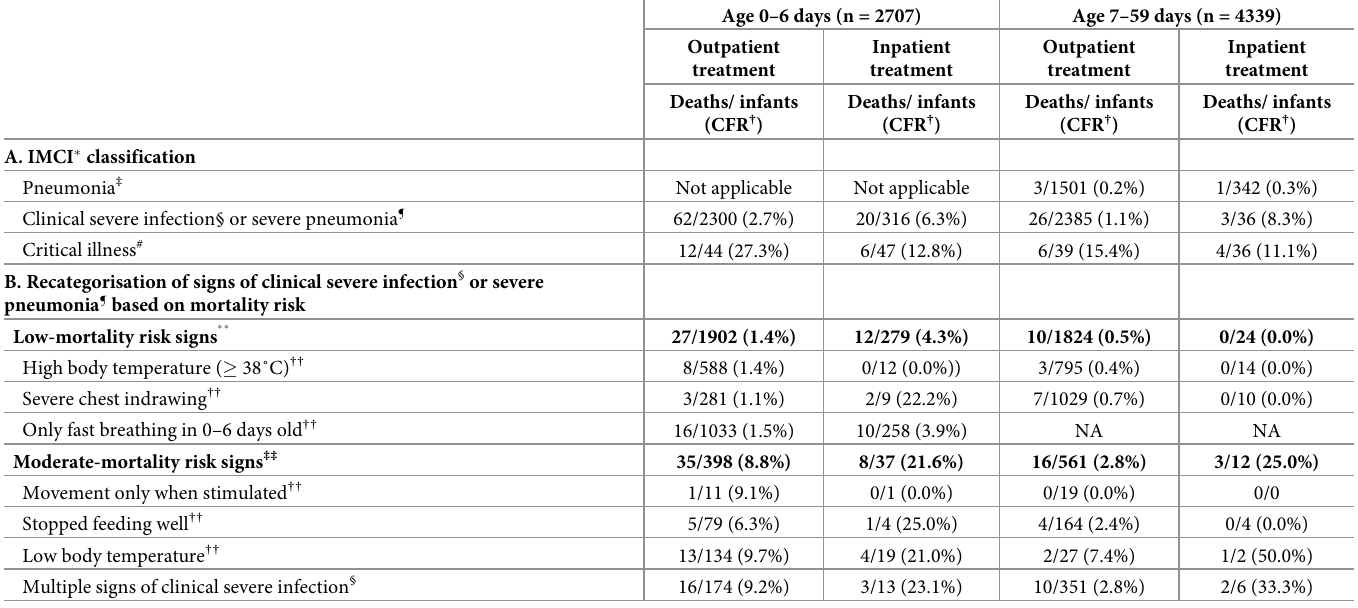
Table 4. Case fatality ratio (CFR) with the place of treatment by age and by IMCI � classification and recategorisation of signs of clinical severe infection or severe pneumonia on mortality risk (n =